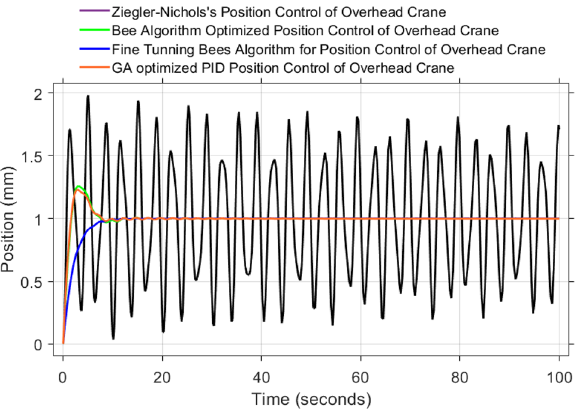
Fig. 6 PID controller result of horizontal motion of the overhead crane using different methods at t = 100 s in one